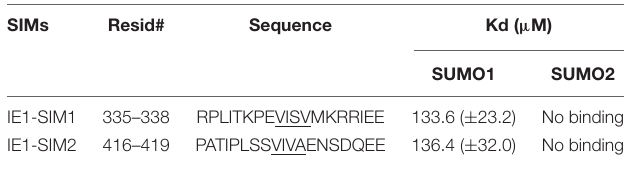
TABLE 1 | The affinity between IE1-SIMs and